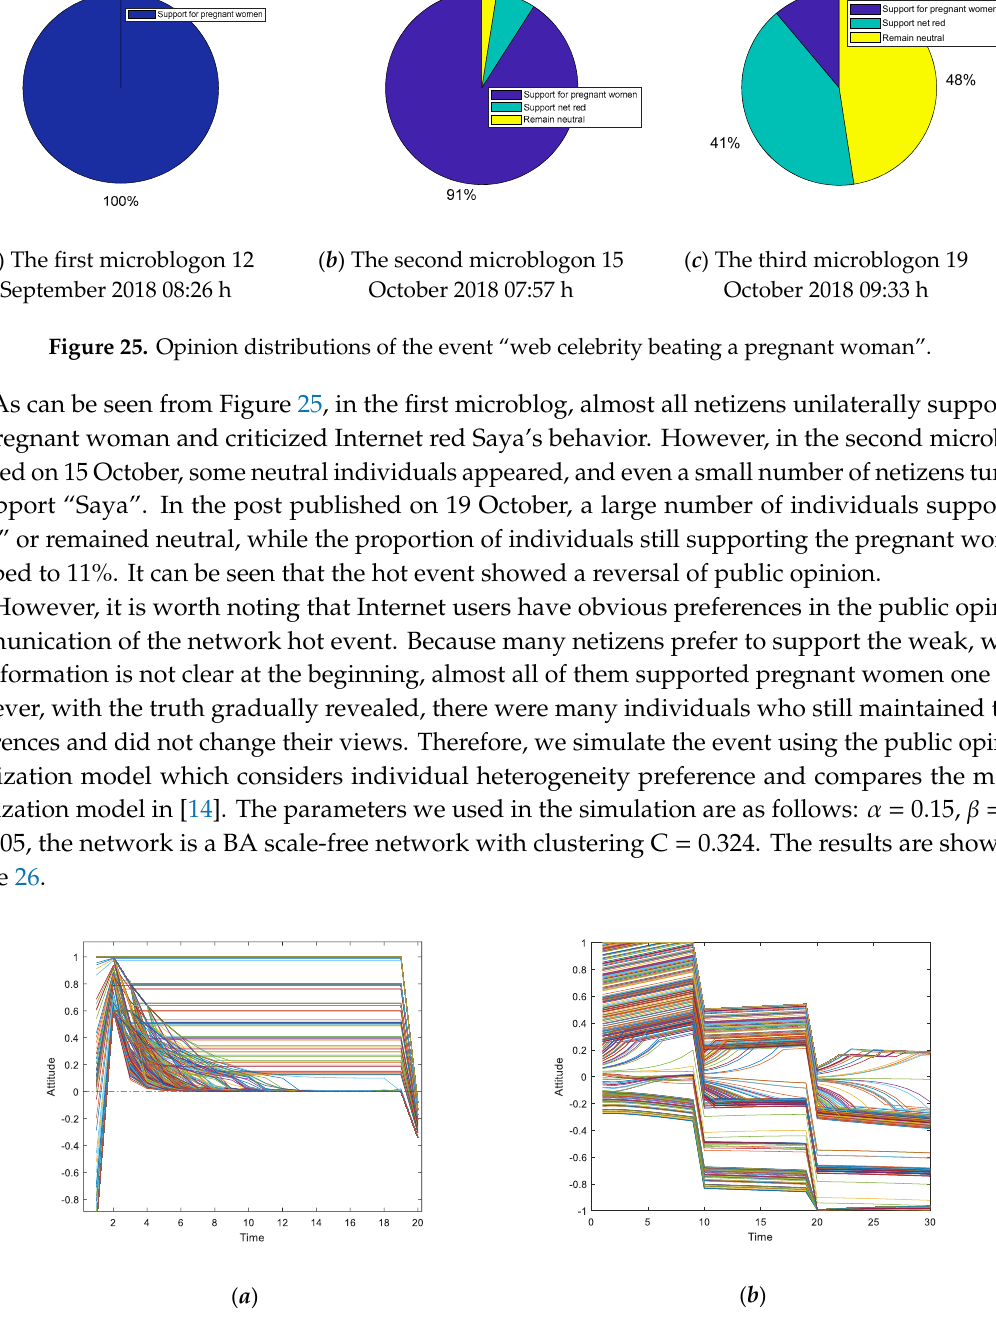
Figure 26. The results of a real case simulation of two models. ( a ) Model which considers individual heterogeneity preference in this paper. ( b ) Macro polarization model in [14].